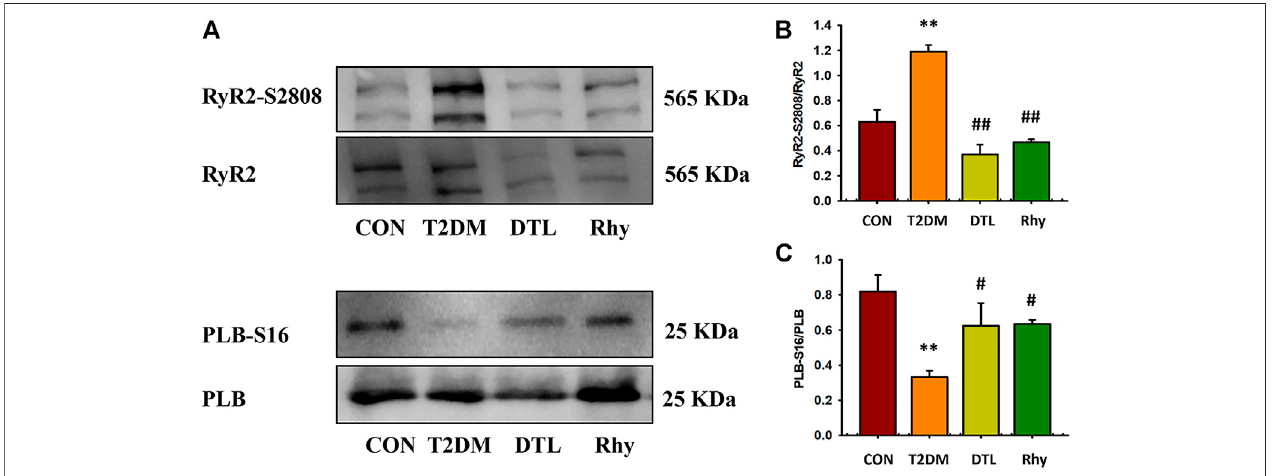
FIGURE 8 | Effect of rhynchophylline on the phosphorylation levels of ryanodine receptor 2 (RyR2) and PLB protein in cardiomyocytes. (A) The phosphorylation protein-expressionlevels ofRyR2-S2808and PLB-S16 were detected by Western blot analysis. (B) The phosphorylation levels of RyR2. (C) The phosphorylationlevels of PLB. Values are presented as mean ± standard error of the mean. ** p < 0.01 vs. control group; # p < 0.05, ## p < 0.01 vs. type 2 diabetes mellitus group.